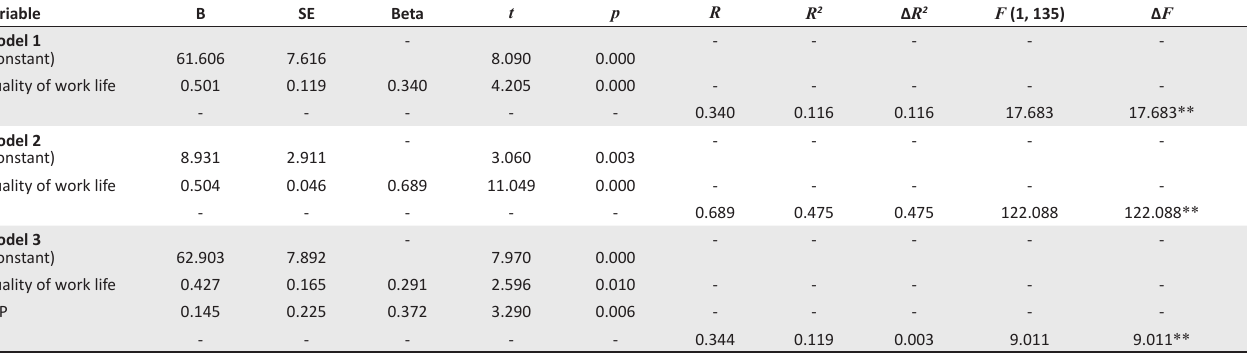
TABLE 4 : Hierarchical multiple regressions for perceived external prestige as mediator in the relationship between quality of work life and organisational commitment.